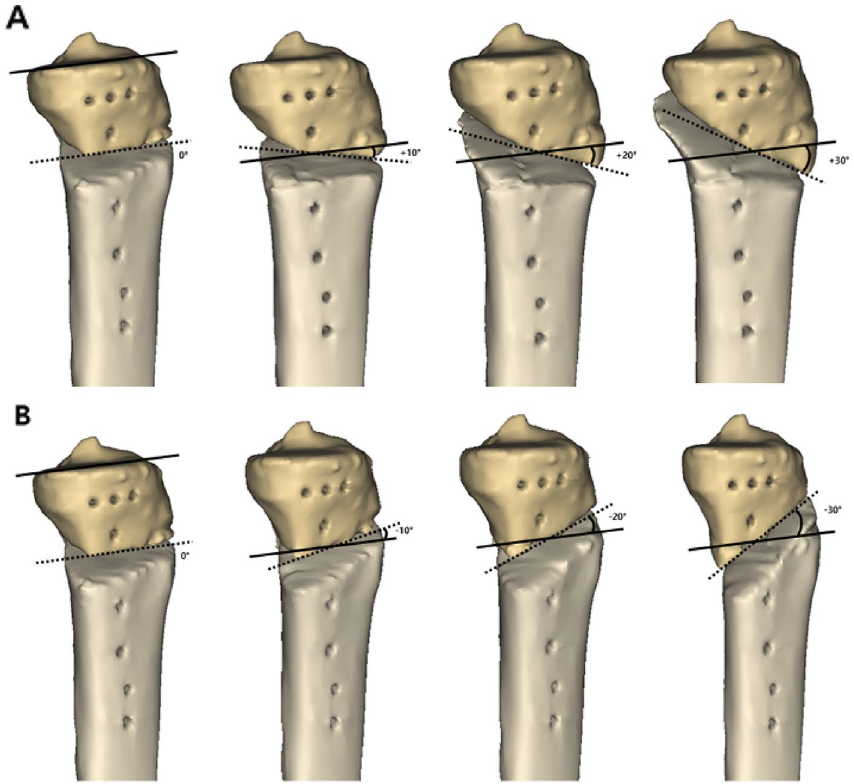
Figure 4. Simulation of osteotomy was performed. Thirteen osteotomy inclination angles in the sagittal plane were applied to the three-dimensional tibial model. The osteotomy inclination angle was changed from − 30° to 30° at intervals of 5° by changing the position of P3. The anterior-to-posterior osteotomy opening gap ratio was maintained at 67%. ( A ) Anteriorly inclined osteotomy (0°, 10°, 20°, 30°). ( B ) Posteriorly inclined osteotomy (0°, − 10°, − 20°, − 30°). These figures were created using the Mimics software (version 17; Materialise, Leuven,